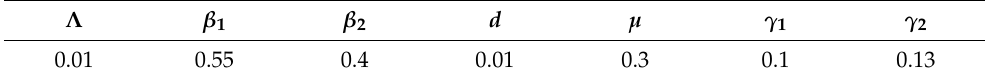
Table 5. Parameter for the SIR-C model.